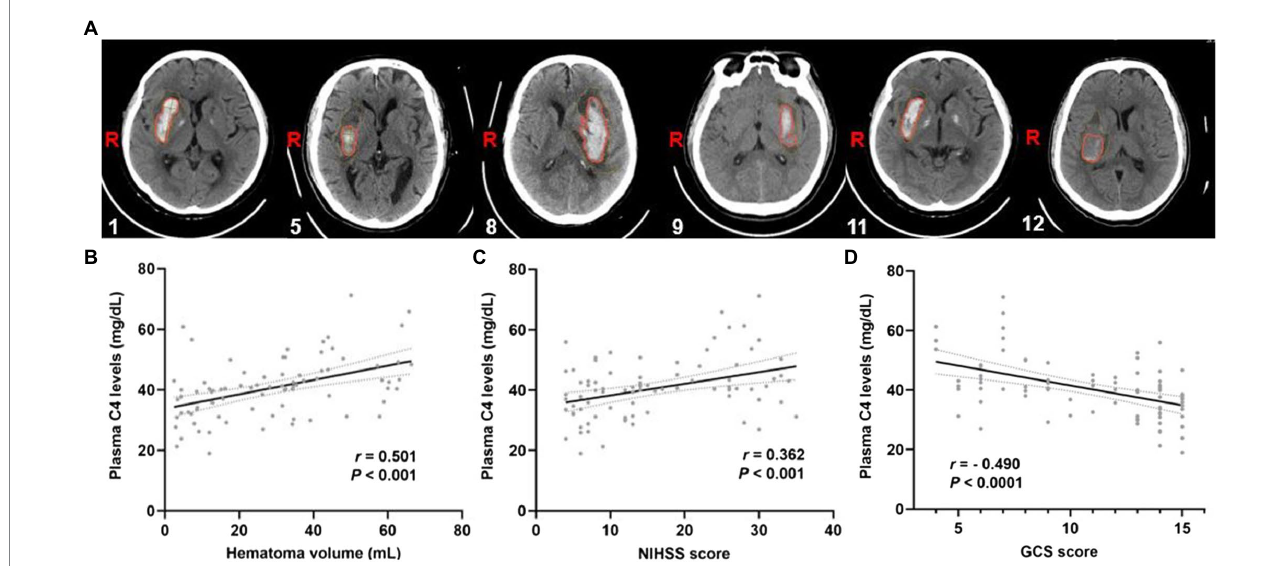
FIGURE 3 Plasma complement C4 levels are positively correlated with the clinical outcomes of the ICH patients. (A) CT images of the ICH patients used for analysis, the corresponding serial number of the patients are listed in the lower left corner of each image. Correlation analysis between the plasma C4 level and (B) hematoma volume, (C) the NIHSS score, and (D) GCS score of the ICH patients ( n = 83). Correlations were done using the Spearman’s correlation coefficient in ICH, plasma C4 levels were closely correlated with hematoma volume, NIHSS score, and GCS score. ICH, intracerebral hemorrhage; NIHSS, National Institutes of Health Stroke Scale; GSC, Glasgow Coma Scale.